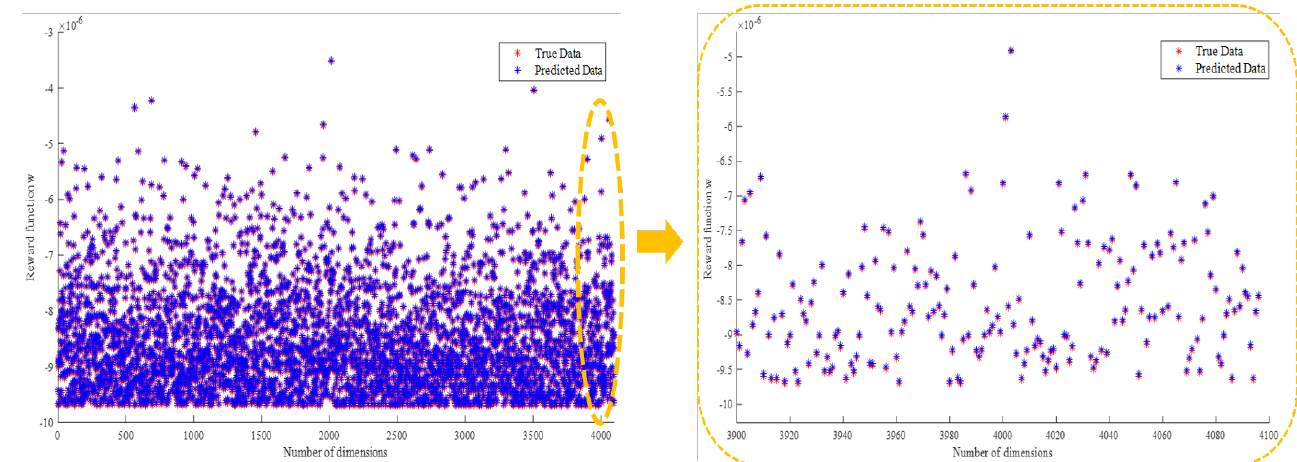
Figure 10. Result after ELM regularization. Blue data points are the output of the regularized ELM and the red points are the true data.